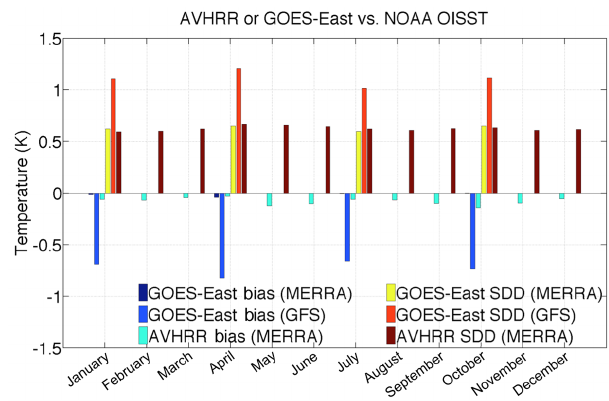
Figure 6. AVHRR (2008) and GOES-13 (2013) SST accuracy and precision relative to NOAA OI SST. For the GEO retrievals, the at- mospheric correction is based on either GFS or MERRA reanalysis. Atmospheric corrections for AVHRR retrievals are strictly based on